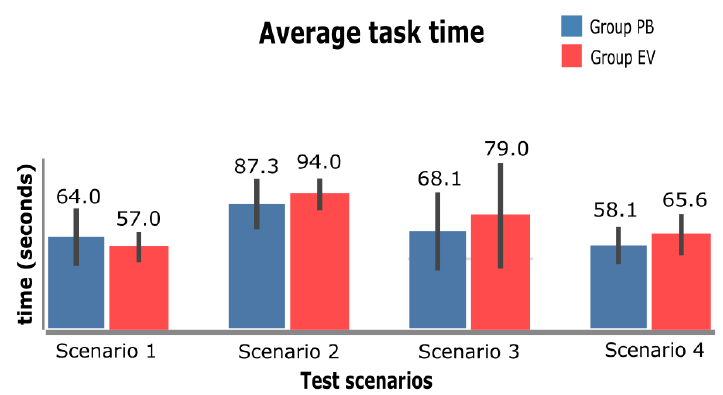
Figure 17. Average time to complete